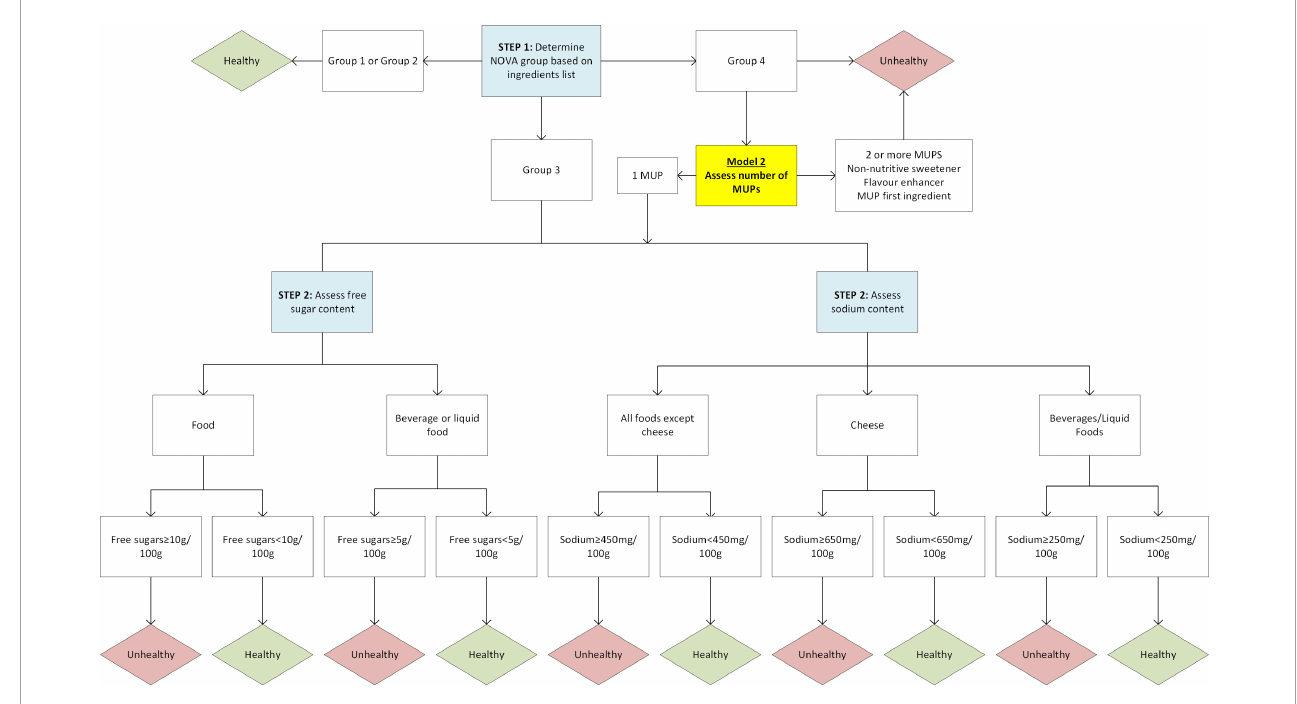
FIGURE1 Flow diagram for classification of Model 1 and Model 2 (variation for Model 2 highlighted yellow).